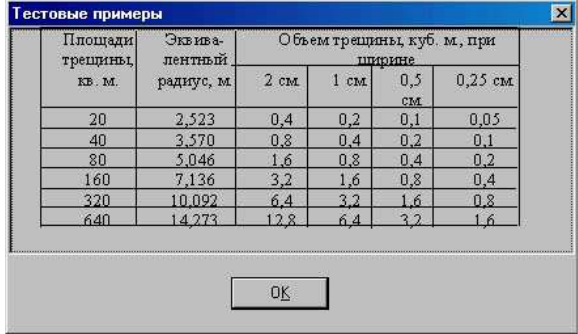
Figure 7: Test examples of calculating the fracture volume